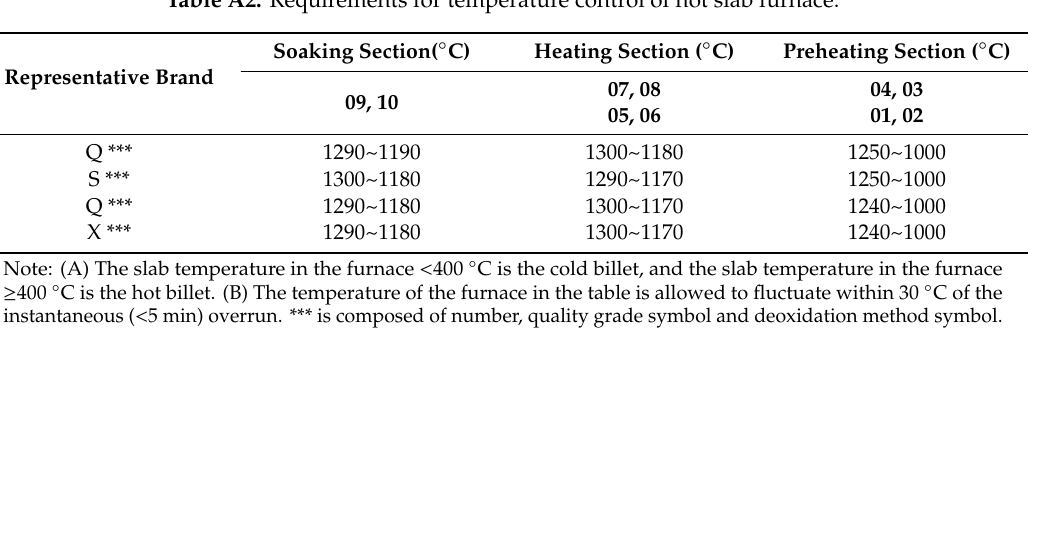
Table A1. Requirements for temperature control of cold slab furnace. Table A2. Requirements for temperature control of hot slab